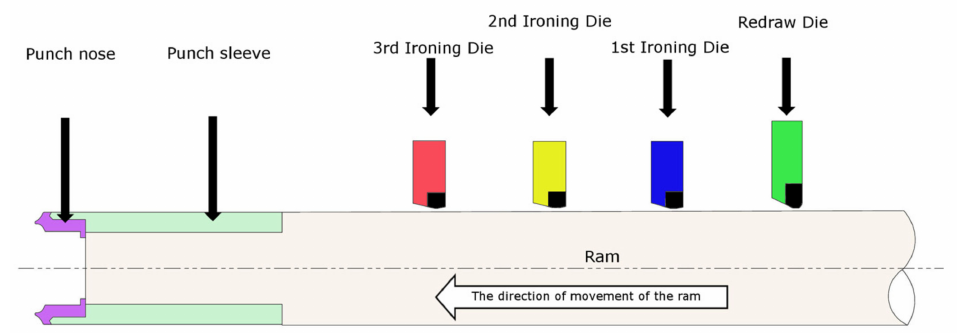
Figure 3. Tool pack sets installed in the